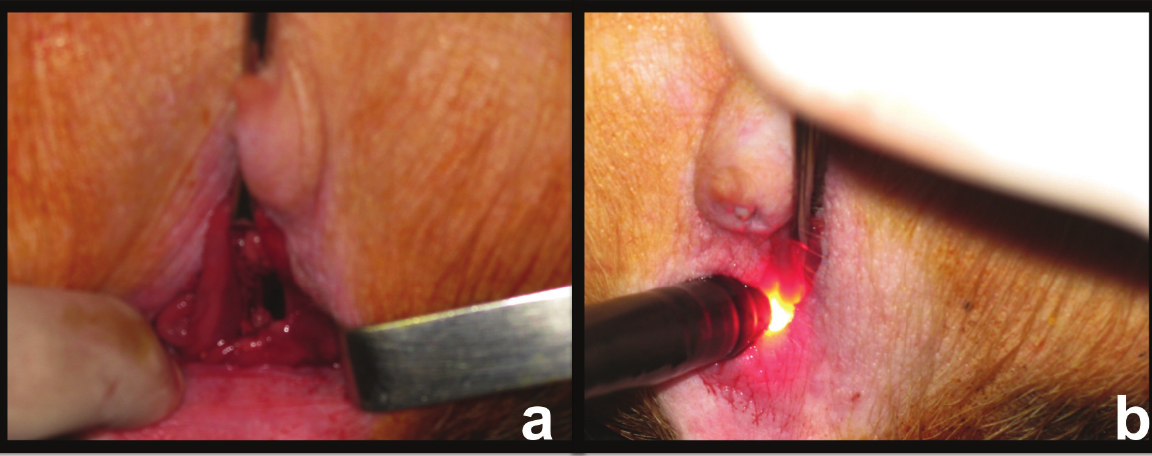
Figure 2 - a. Identifi cation of the anal verge and incision in swine models. b . Insertion of the colonoscope directly into the retroperitoneal space in swine